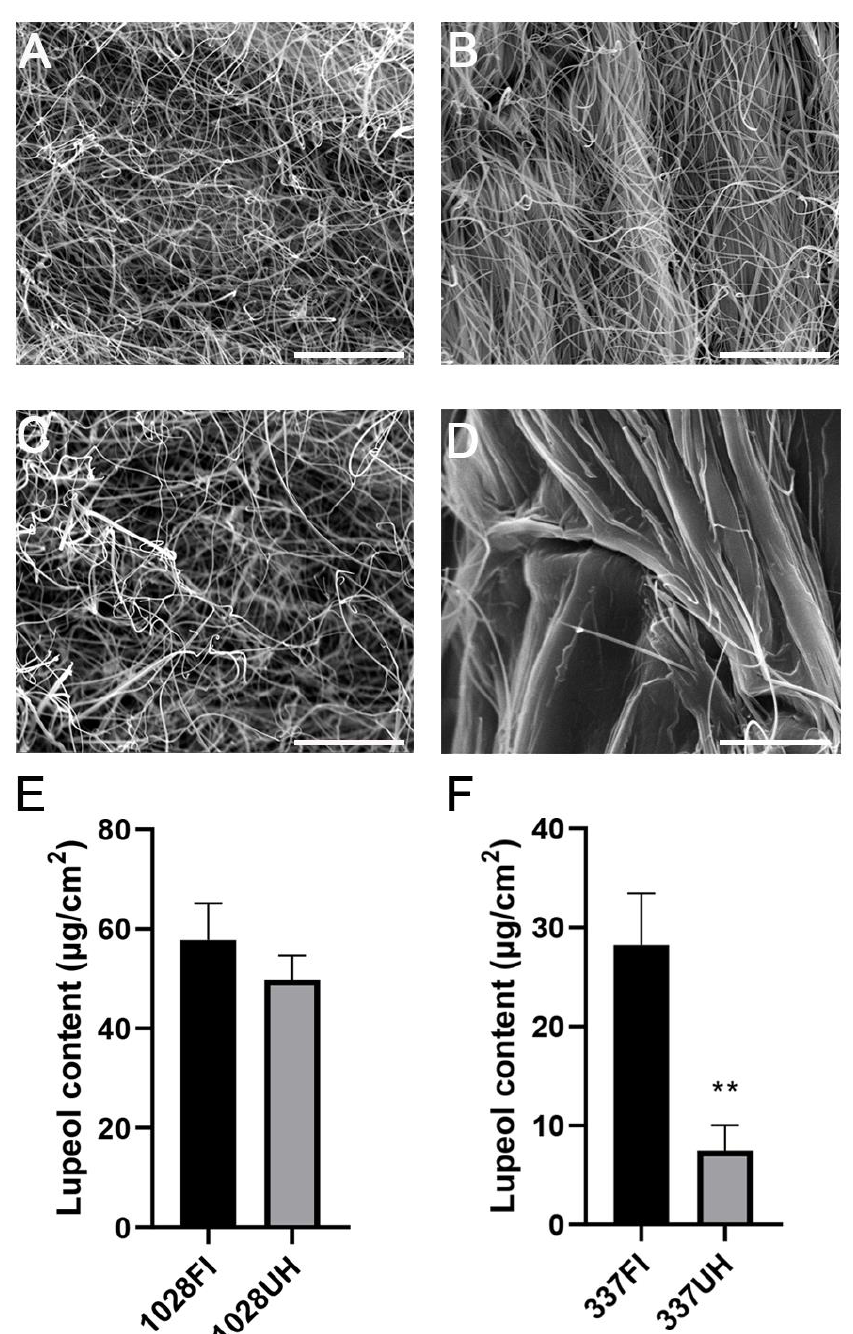
Figure 1. Wax phenotype of castor upper hypocotyl and first internode of castor accession lines 1028 and 337. SEM analysis was performed to check wax crystals coating on the first stem inter- node (FI) of 1028 ( A ) and 337 ( B ) as well as upper hypocotyl (UH) of 1028 ( C ) and 337 ( D ), respectively. Bar = 10 μm. ( E , F ) Lupeol content in the FI and UH of 1028 and 337. The black and grey boxes indicate the lupeol content of FI and UH accordingly. ** P < 0.01. Error bars represent ± SD ( n = 3–4).